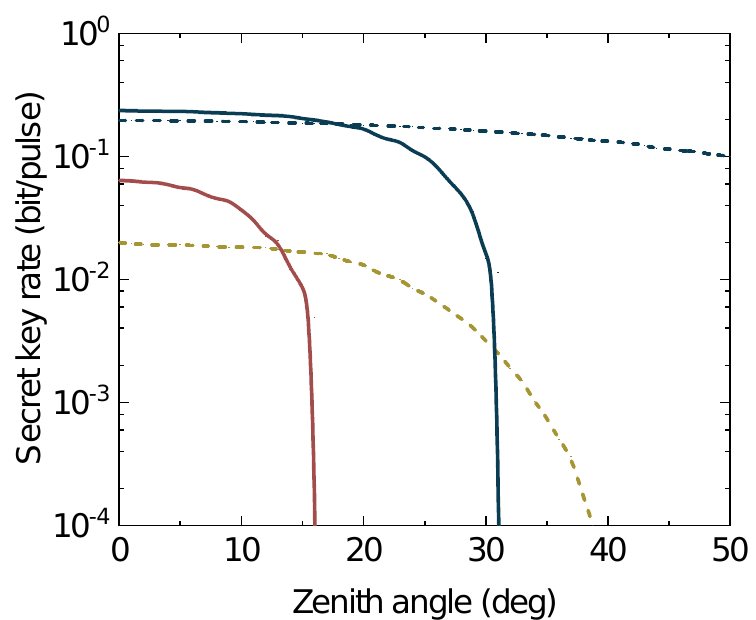
Figure 2. Secret key rate vs. zenith angle for different scenarios: downlink (dashed line) and uplink (solid line). The blue, red, and yellow lines represent the satellite altitude of 100 km, 120 km, and 800 km,